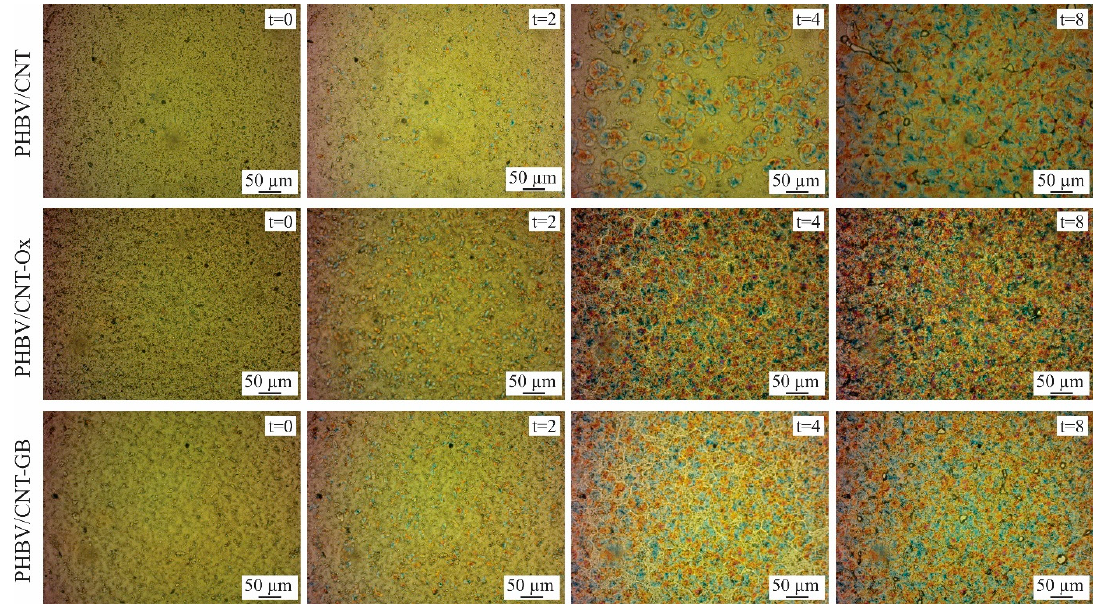
Figure 9. Polarized light optical microscopy images of PHBV/CNT, PHBV/CNT-Ox, and PHBV/CNT-GB at times t = 0, t = 2 min, t = 4 min, and t = 8 min.